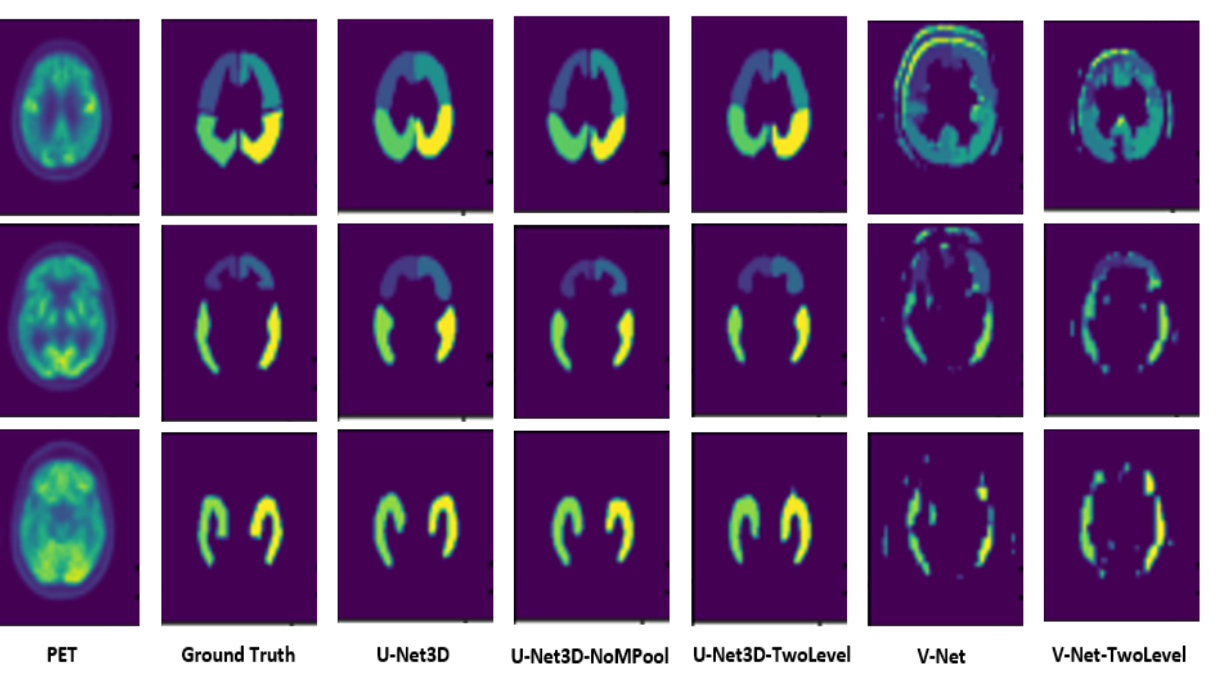
Figure 4. Segmentation results from a normal subject’s volume. First column: 18F-FDG slices; second column: ground truth; third–fifth columns: results of the automatic segmentation using the proposed models.